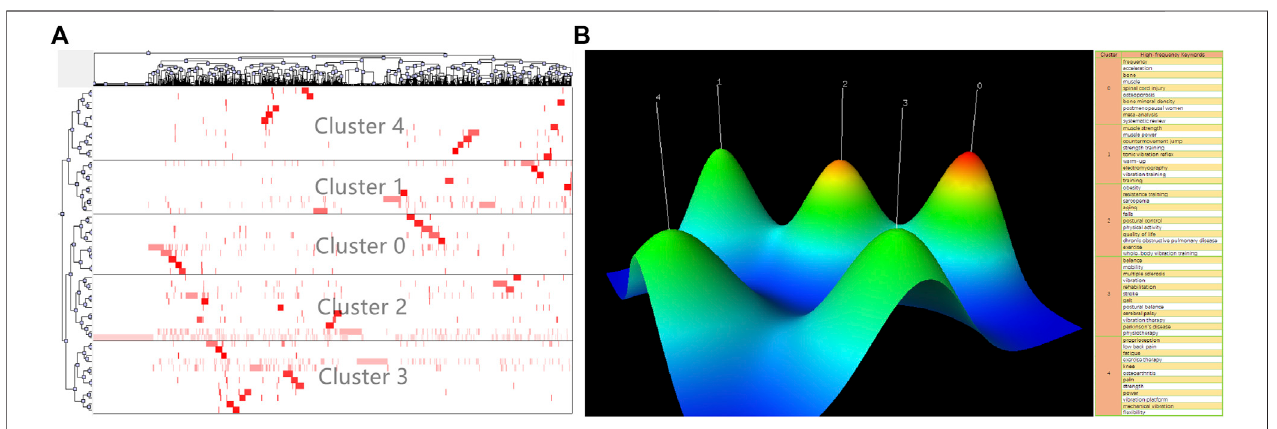
FIGURE 8 | Biclustering analysis of the high-frequency word – paper matrix on WBVT. (A) Tree visualization; (B) Mountain visualization.